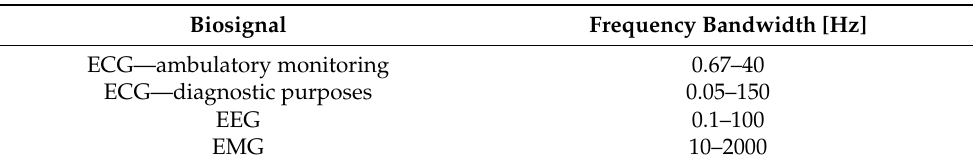
Table 1. Frequency ranges of biosignals. Reprinted with permission from ref. [1]. Copyright